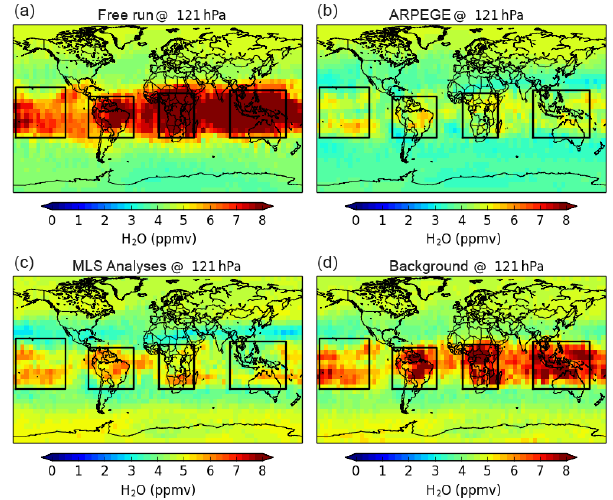
Figure 7. Monthly averaged H 2 O fields at 121hPa in January 2012 in the MLS observation space (in time and space coincidence with MLS observations) from the free run (MOCAGE, a ), ARPEGE (b) , MLS analyses (assimilation, c ) and the background (d)